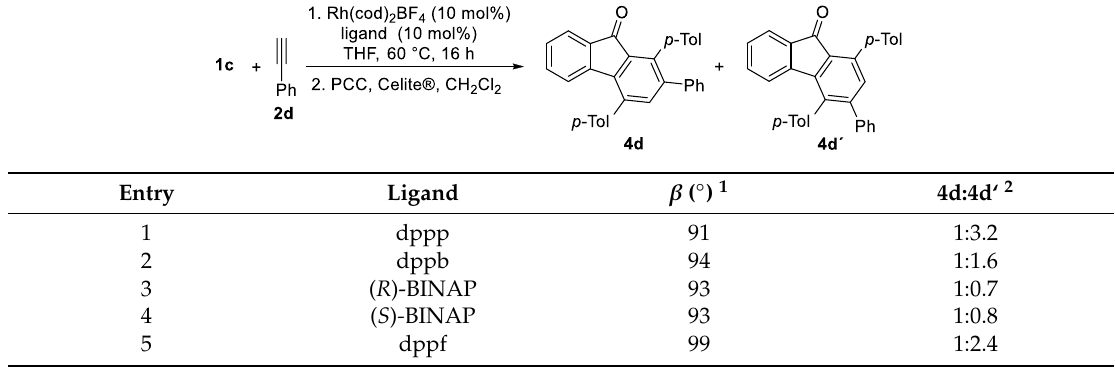
Table 2. Cyclotrimerization of 1c with 2d catalyzed by Wilkinson’s catalyst.